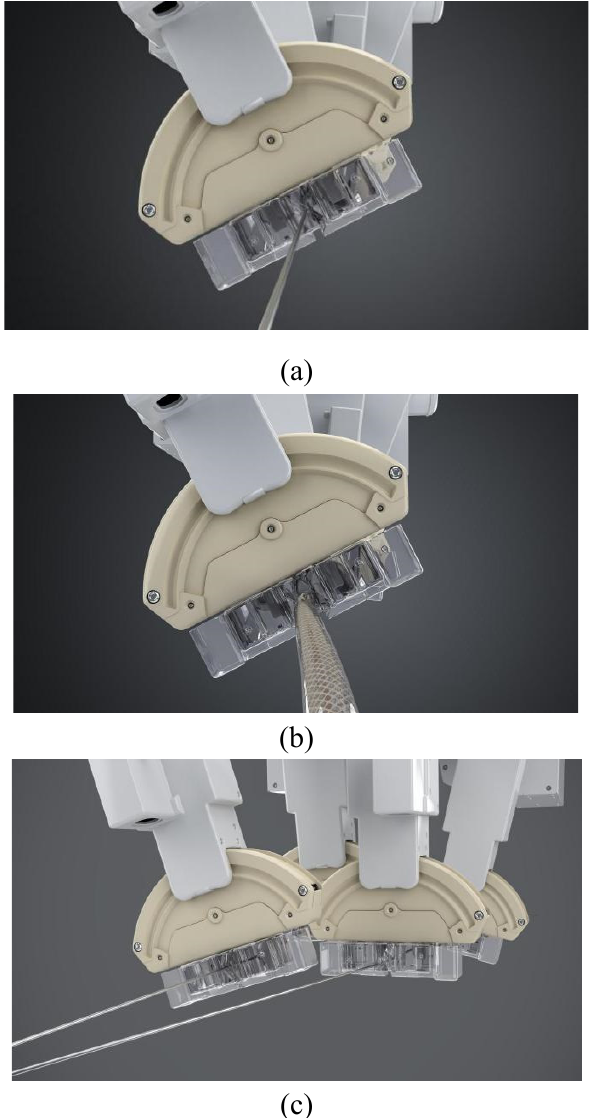
Figure 3. ( a ) Coaxial state of four manipulators (guidewire); ( b ) Coaxial state of four manipulators (stent graft); ( c ) Non-coaxial state of four manipulators (rapid exchange system).